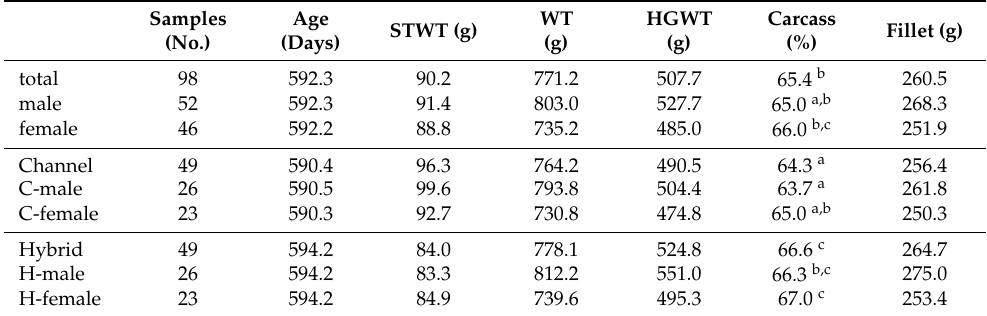
Table 7. Catfish production and processing data for frozen hybrid and channel